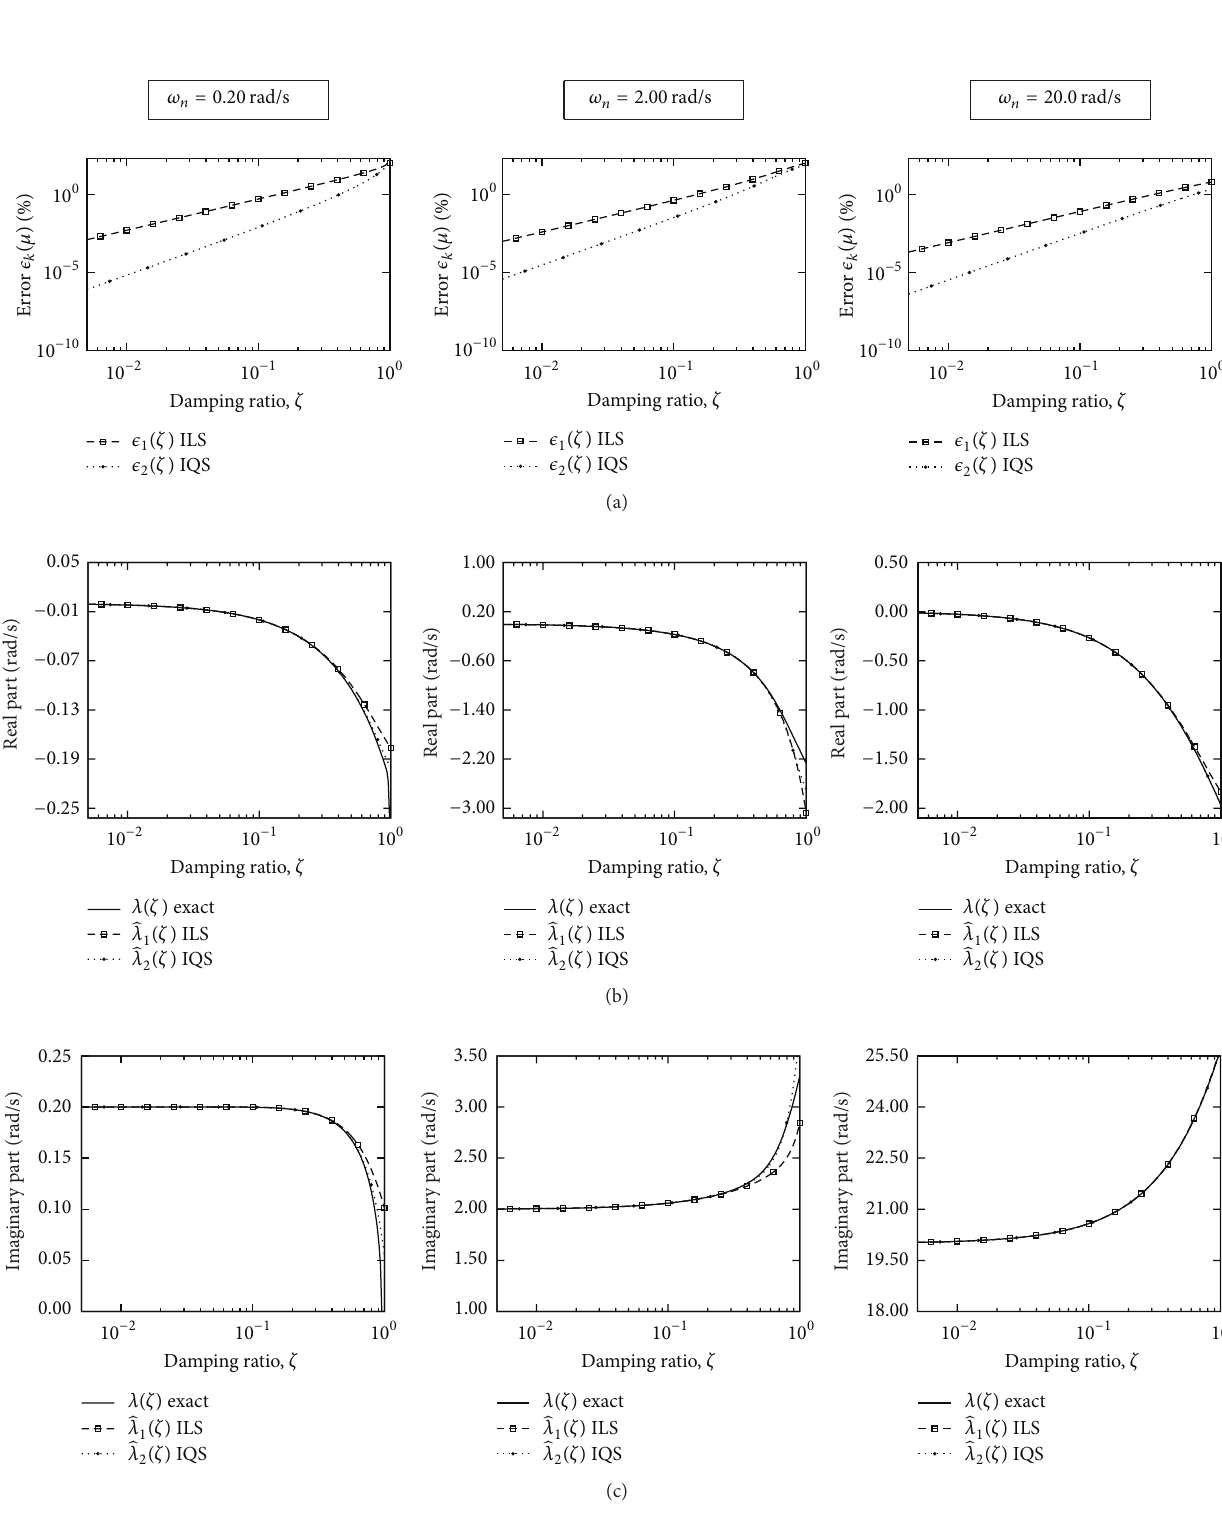
Figure 5: Case 𝜃 = 𝜁 for Biot’s multiexponential model 𝜇 𝑗 = {2, 4,6, 10, 15} rad/s. Relative error 𝜖 𝑘 (𝜁) = |Ψ−𝜓 𝑘 |/|Ψ| of the integrand function (a). Eigenvalues versus parameter 𝜁 (b and c). Continuous line for exact values and dotted one for Improved Solutions: square tick for Linear (ILS) and bullet for Quadratic